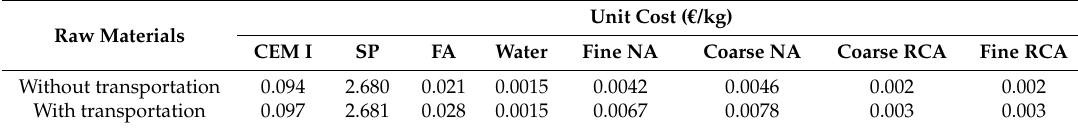
Table 2. Unit cost of the raw materials; CEM I: ordinary Portland cement; SP: superplasticizers; NA: natural aggregates.